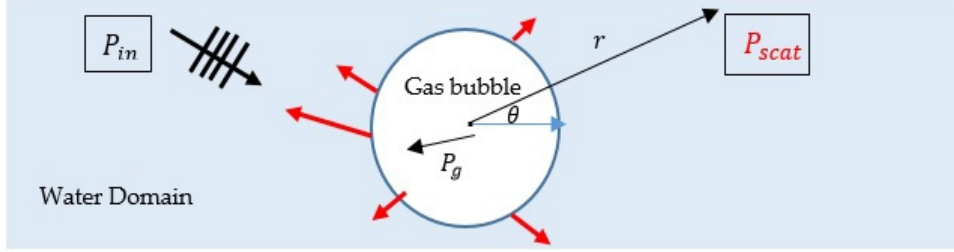
Figure 3. Gas bubble scattering geometry considering a spherical gas bubble with a radius a in water infinite domain influenced by an incident acoustic plane wave P in with wavelength λ . The gas bubble re-radiates scattered fields (red arrows) into the water in all directions with different intensities. The scattering pressure P scat in range r and angle θ is calculated using Equation (4). P g is the gas pressure inside the bubble .